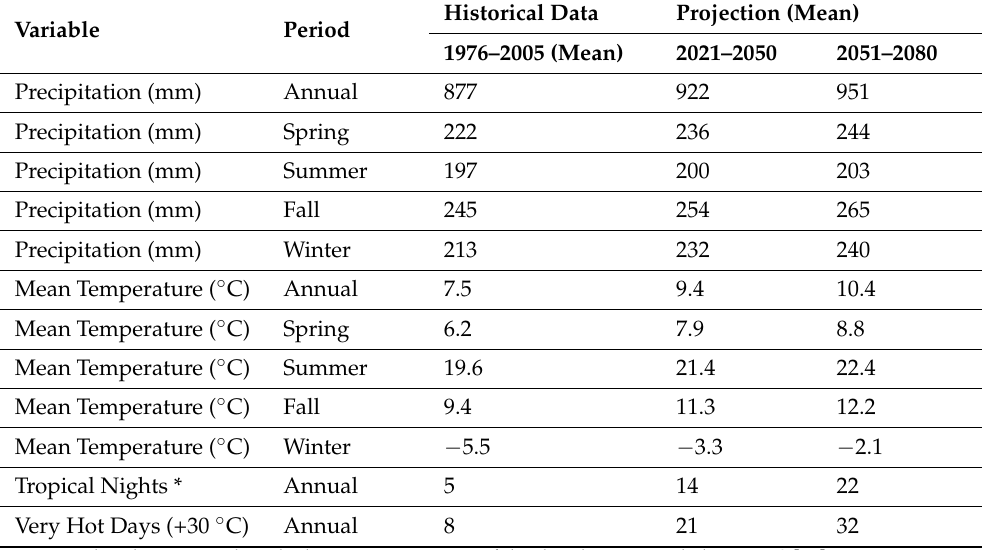
Table 5. Historical data and future climate projection (RCP4.5: low carbon climate scenario) for Prince Edward County. Adopted from Ref.